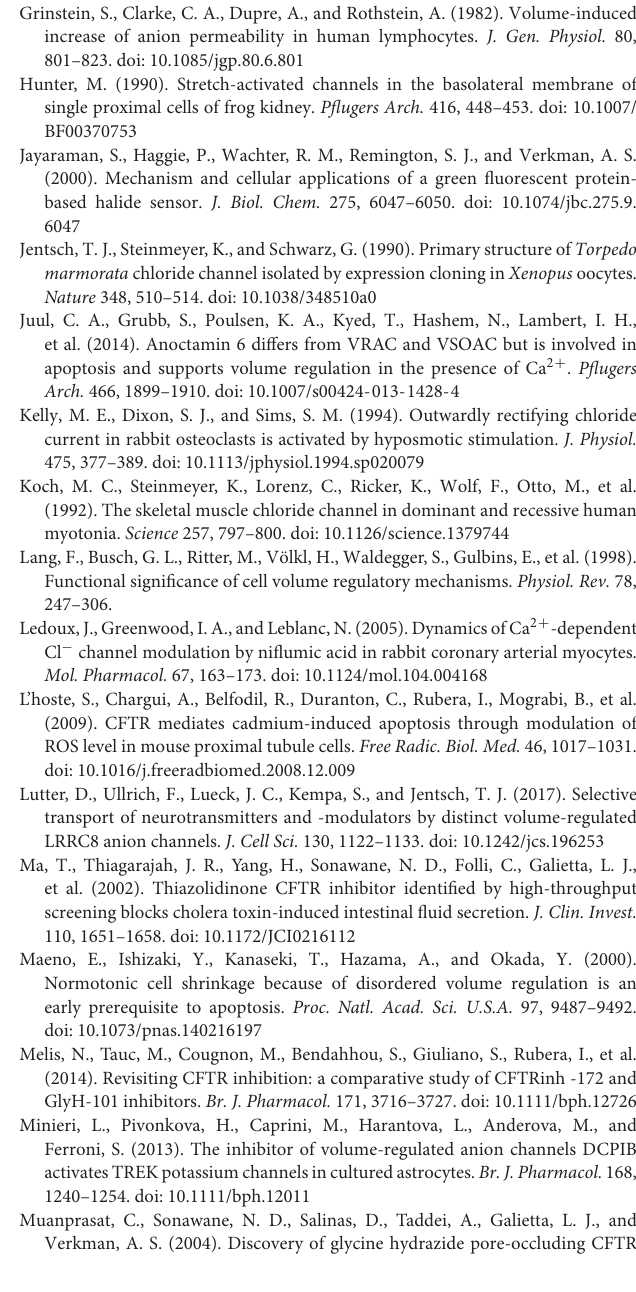
FIGURE S3 | Absence of CFTR inh -172-mediated inhibitory effect on I Cl , swell . (A) Mean current/voltage relationships measured 10 ms after the onset pulse corresponding to experiments performed in Figure 4 in the absence or presence CFTR inh -172 (20 µ M, n = 5 of individual records). (B) Dose-response inhibition curve calculated from whole-cell current recordings of cells exposed to 1, 10, and 20 µ M CFTR inh -172. The percent inhibition induced by CFTR inh -172 at − 100 mV was calculated for each concentration ( n = 5 for each experimental concentration). FIGURE S4 | Basal fluorescence of GlyH-101-impeded regulatory volume decrease measurement. The calcein relative fluorescence method is impeded by the basal auto-fluorescence of GlyH-101 (10 µ M, n = 8). Experiments were performed without hypotonic challenge; the same iso-osmotic solution (300 mOsm.l − 1 ) was maintained during all of the